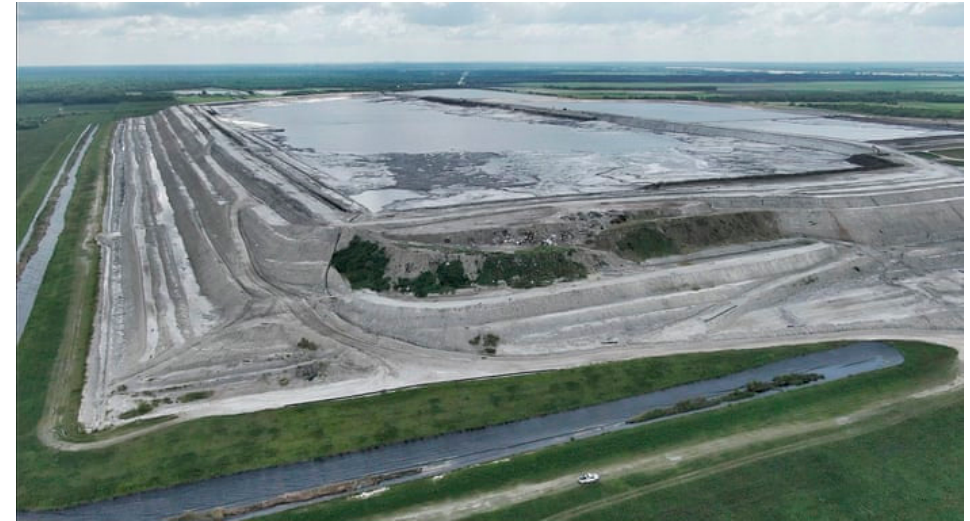
Figure 7. Phosphogypsum stacks in Florida (The Mosaic pile. Photograph: Phin Percy).